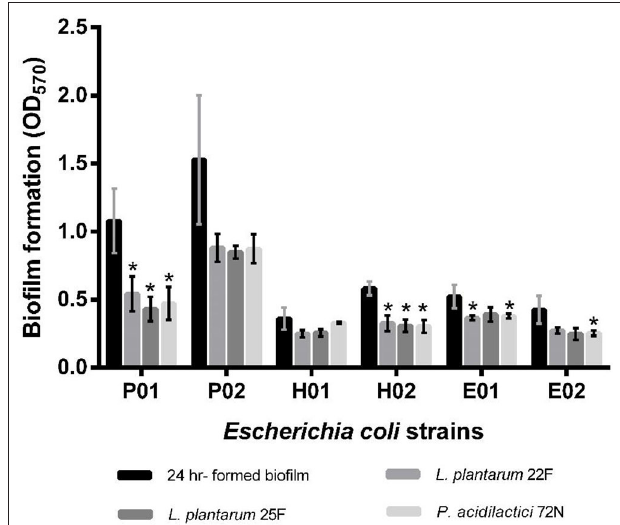
FIGURE 3 | Effects of non-neutralizing CFS of LAB on sessile biofilm of by E. coli evaluated by crystal violet assay. A significant difference (* P < 0.05) was calculated by an independent t -test when compared with the control